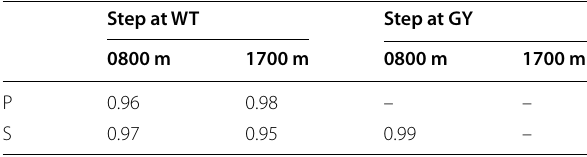
The amplitude ratio of the transfer functions before and after the earthquakes in each sensor and each phase. “–” indicates that no significant change was observed